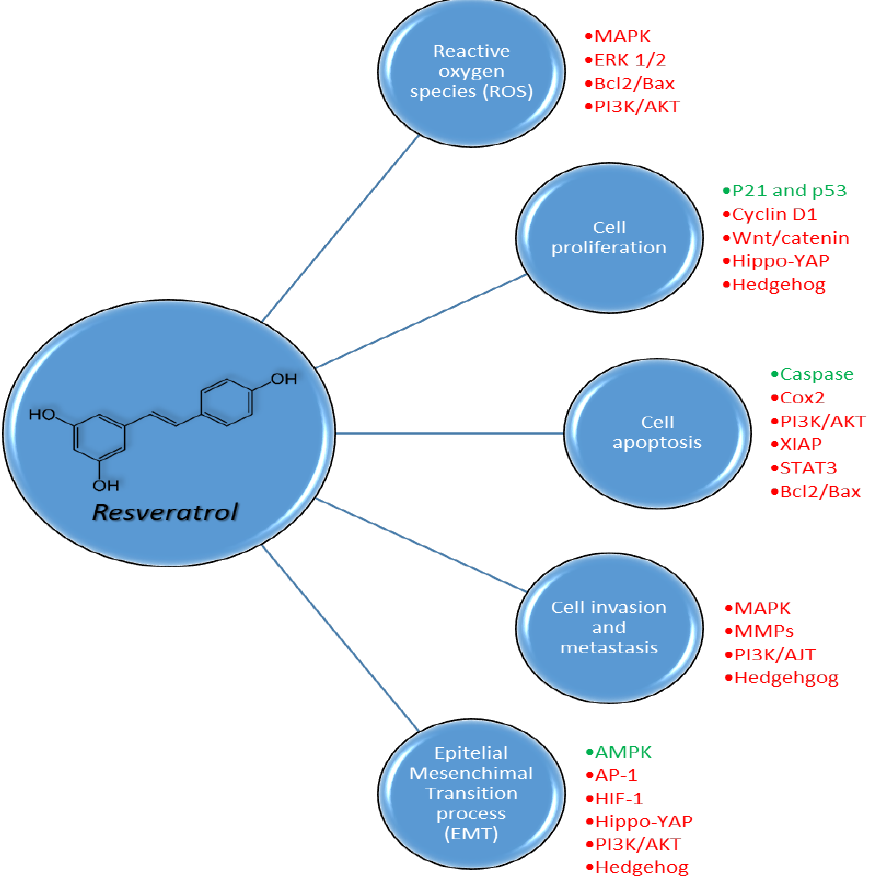
Figure6. Pleiotropicbiochemicale ff ectsofresveratrolonreactiveoxygenspecies(ROS),cellproliferation, cell apoptosis, cell invasion and metastasis and epithelial mesenchymal transition processes in cancer cells through the activation (green) or inhibition (red) of di ff erent